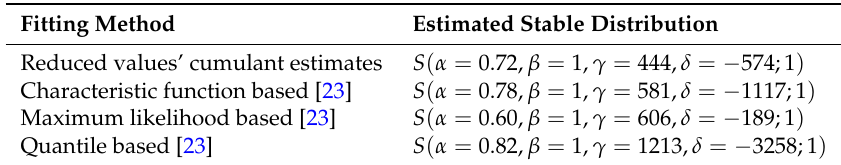
Table 7. Modelling non-life insurance losses ( n = 2802) via stable distributions.